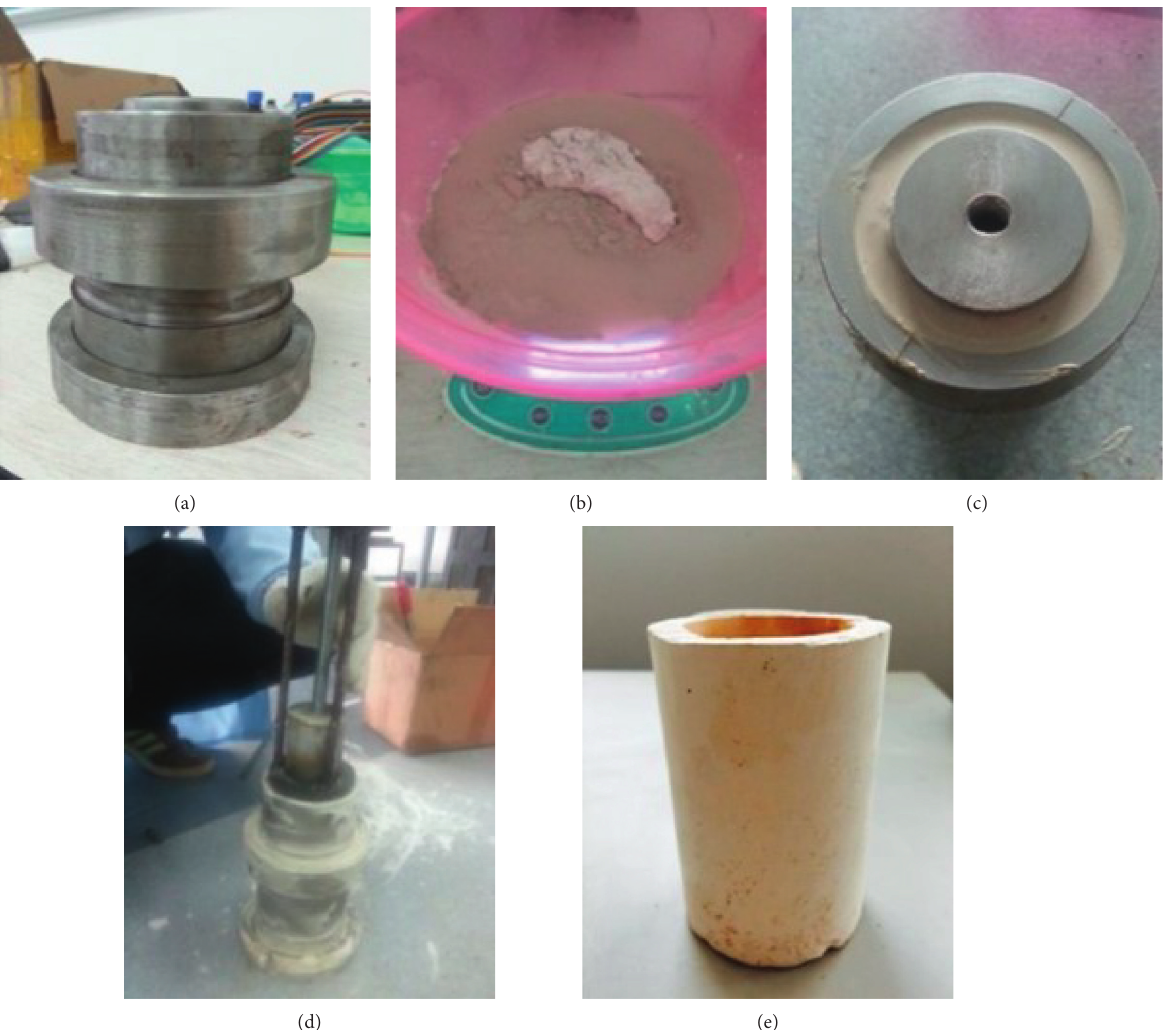
Figure 4: Schematic diagram of segment mode. (a) Mould. (b) Weighing. (c) Pouring model. (d) Removing the mould. (e) Model of the segment.